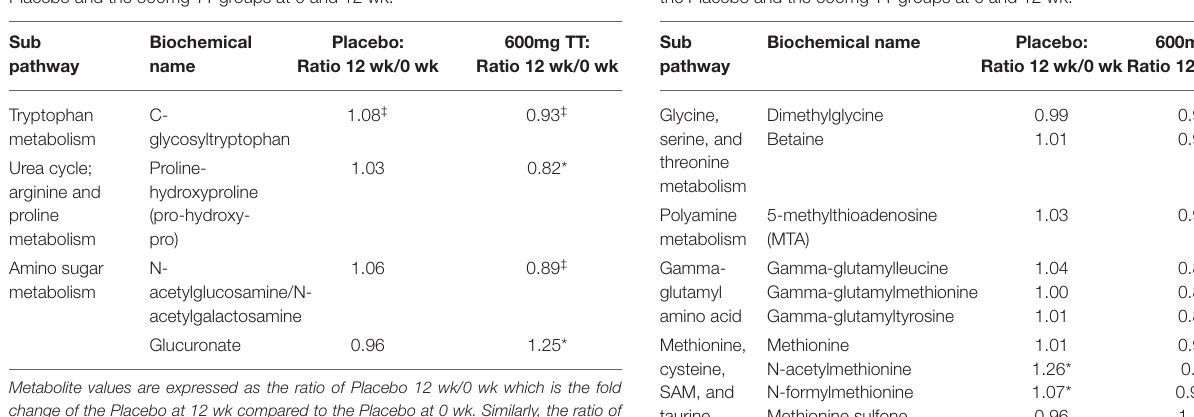
TABLE 1 | Changes in metabolites associated with bone matrix in serum of the Placebo and the 600mg TT groups at 0 and 12 wk.